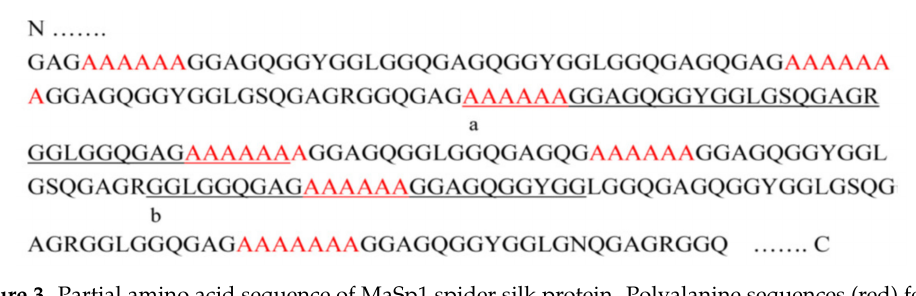
Table 1. 47-mer peptides as the sequential models of the Gly-rich region in Figure 3 as underlined sequence, a flanked by (Ala) 6 at both ends [46,60,62]. (I) The peptides, 2–7 were used for determinations of both the inter-nuclear distances of 15 N and 13 C labeled sites, and the fractions of the local conformations of 13 C labeled Gly residues. (II) The peptides, 8–10 were used for determination of the fractions of the local conformations of the 13 C labeled Gly-Ala-Gly motifs.